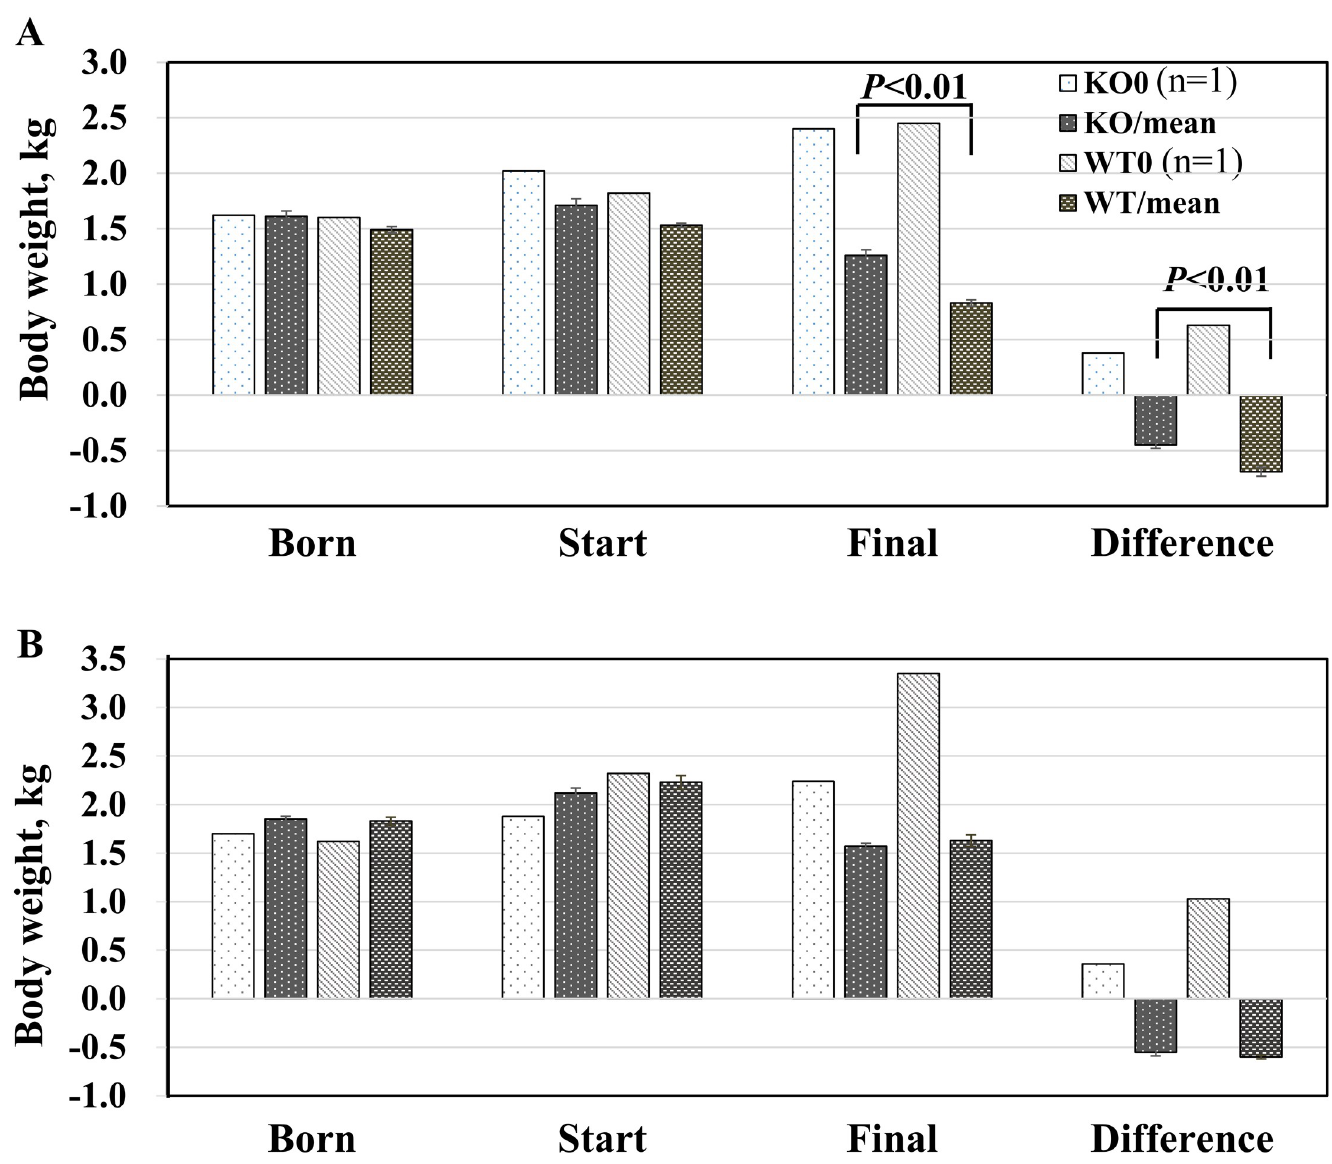
Fig 7. Body weights of neonatal piglets before and after oral PEDV inoculation. A. 2-day-old piglets (n = 6) and B. 3-day-old piglets (n = 9) in Exp. I and Exp. II, respectively, show body weights changes 72 h after inoculated with nv-PEDV. K0 and W0 represent KO and WT animals that were not inoculated with PEDV and were reared by their dams on the farm. KO and WT are knockout treated and wild-type treated animals, respectively.